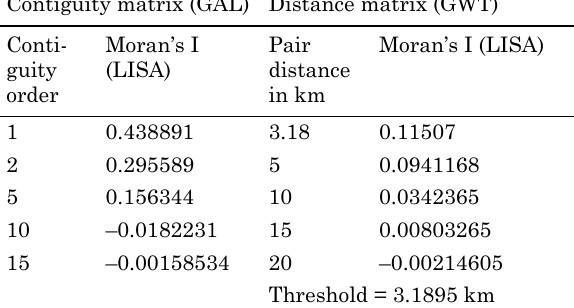
Table 1. Evidence of local spatial autorregression in Vega Baja, Alicante at local level Contiguity matrix (GAL) Distance matrix (GWT)